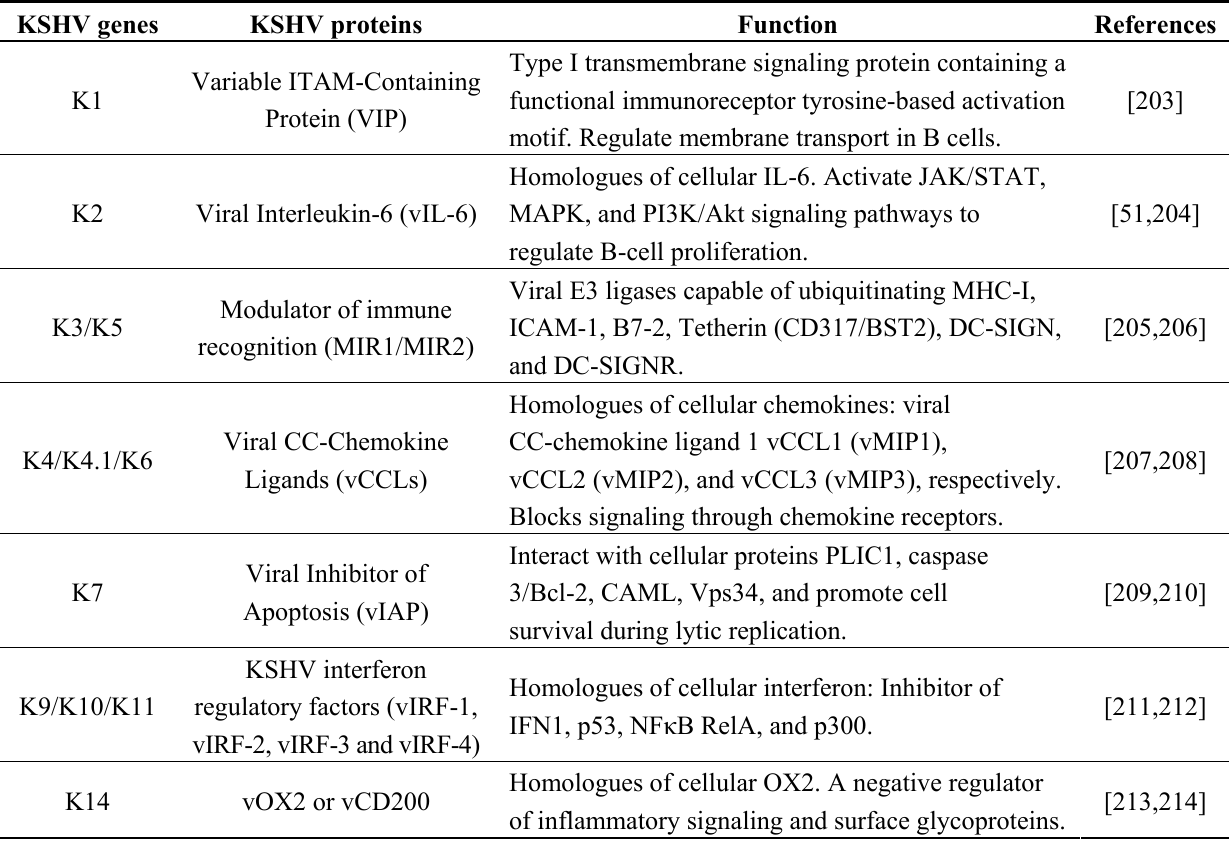
Table 1. KSHV lytic proteins involved in immune modulation and